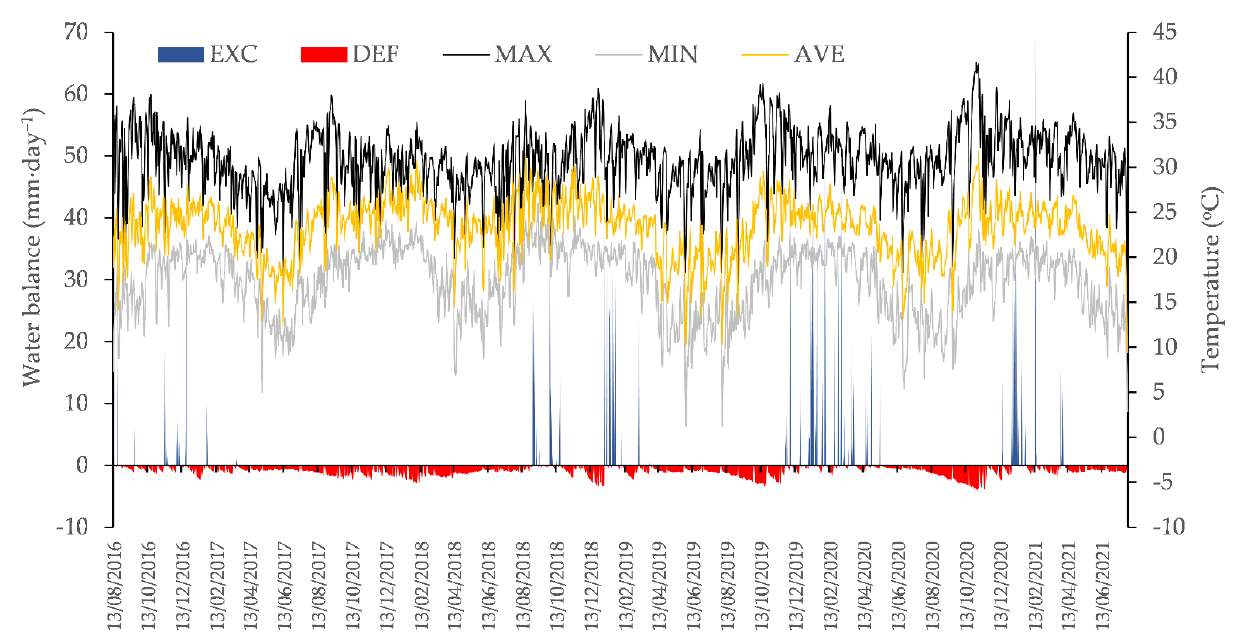
Figure A1. Daily air temperature [maximum (MAX), minimum (MIN) and average (AVE)] and daily water balance (EXC, excess; DEF, deficit) for the 2016–2021 period at the experimental area in Onda Verde, SP, Brazil. The sequential water balance and actual evapotranspiration were calculated between assessment dates as proposed by [57] using an available water capacity of 100 mm. The potential evapotranspiration was estimated using the FAO-56 Penman–Monteith (FAO PM) method [58].